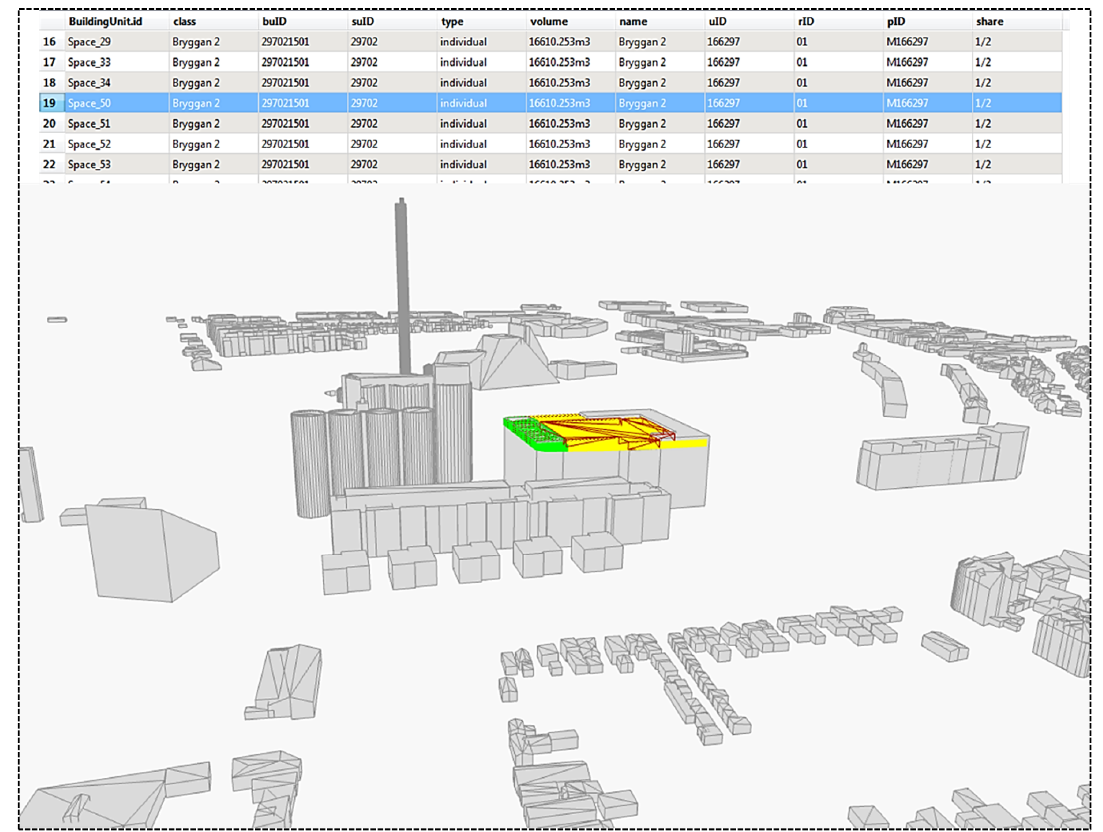
Figure 20. A simplified 3D cadastral index map based on integration of CityGML 3.0 and LADM DB with neighboring buildings. Bryggan 1 is in green color and Bryggan 2 in yellow. This should be compared with the current 2D cadastral index map in Figure 7.